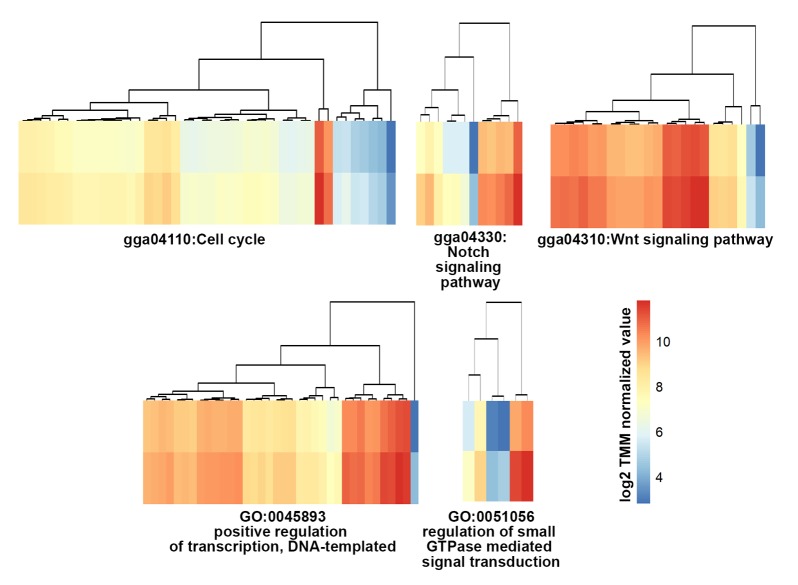
Functional classification of genes by maternal genome activation during the 1st wave of transcriptional activation and tracing through early development.Heatmaps showing the expression patterns of the transcripts that are significantly upregulatedbetween oocyte and zygote (FDR-adjusted st<0.05 and logFC >0) in terms of biological processes in Gene Ontology (GO) and KEGG pathway enrichment.